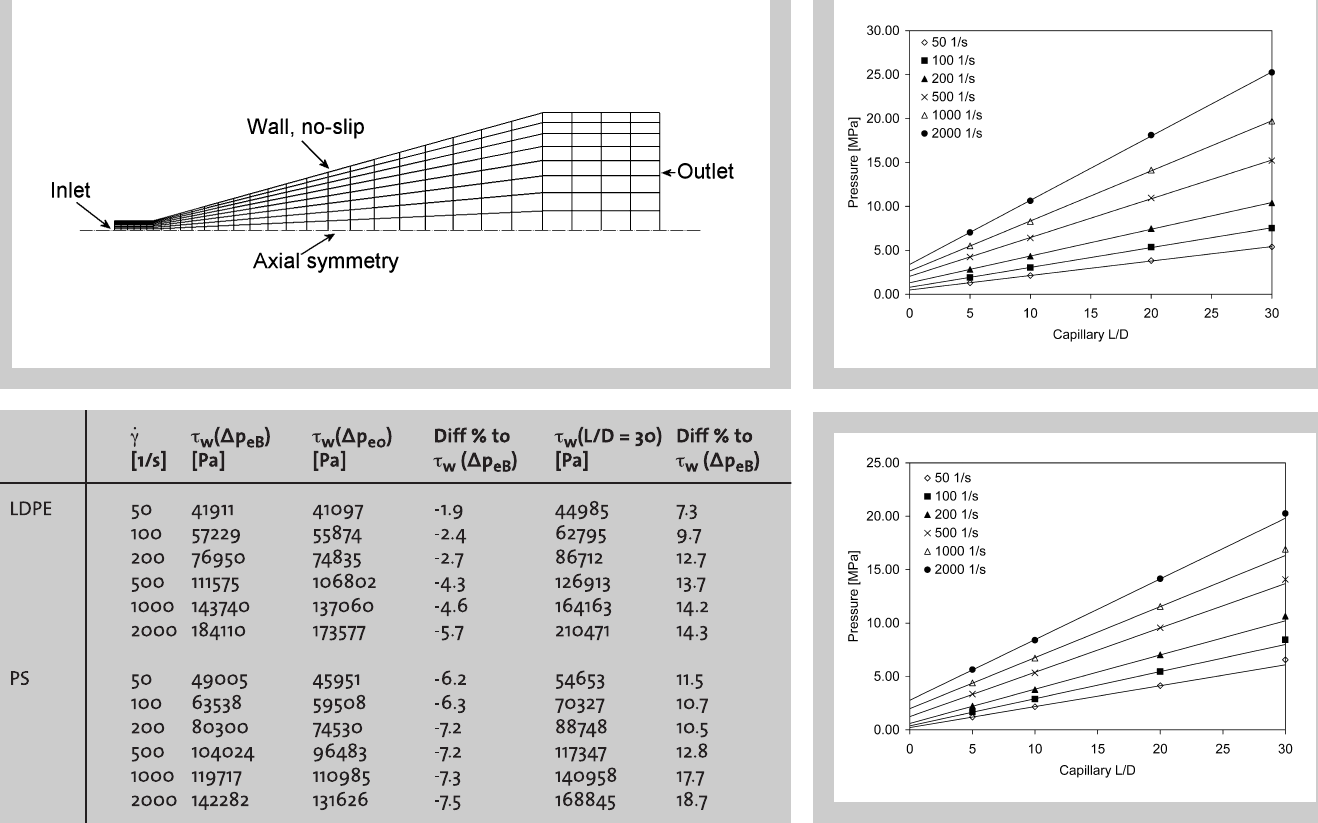
Figure 2 (left above): Finite element mesh with boundary conditions. Figure 3 (right above): Bagley plot for LDPE at dif- ferent apparent shear rates using linear fits to the data from capillaries L/D = 5, 10, 20, and 30. Figure 4 (right below): Bagley plot for PS at differ- ent apparent shear rates using linear fits to the data from capillaries L/D = 5, 10, and 20 (note that experi- mental data points for L/D = 30 are only given for purposes of illustration). Table 1: Shear stress at capillary wall; corrected by Bagley ( D p ), corrected method, t w eB with orifice die, t ( D p ), w e0 uncorrected, t (L/D = 30), w and percentage differences of the latter two to t ( D p w eB